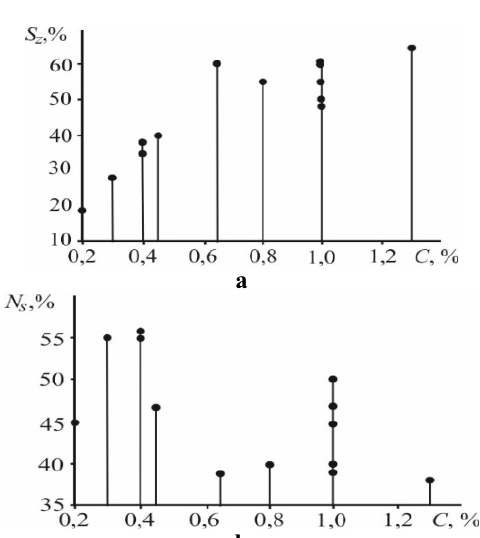
Figure 3. Chemographic prints of sample materials: a – Steel 45; b – D16; c – AL9; d – NC332; e, f – T15K6 + TiN (new (e) and used